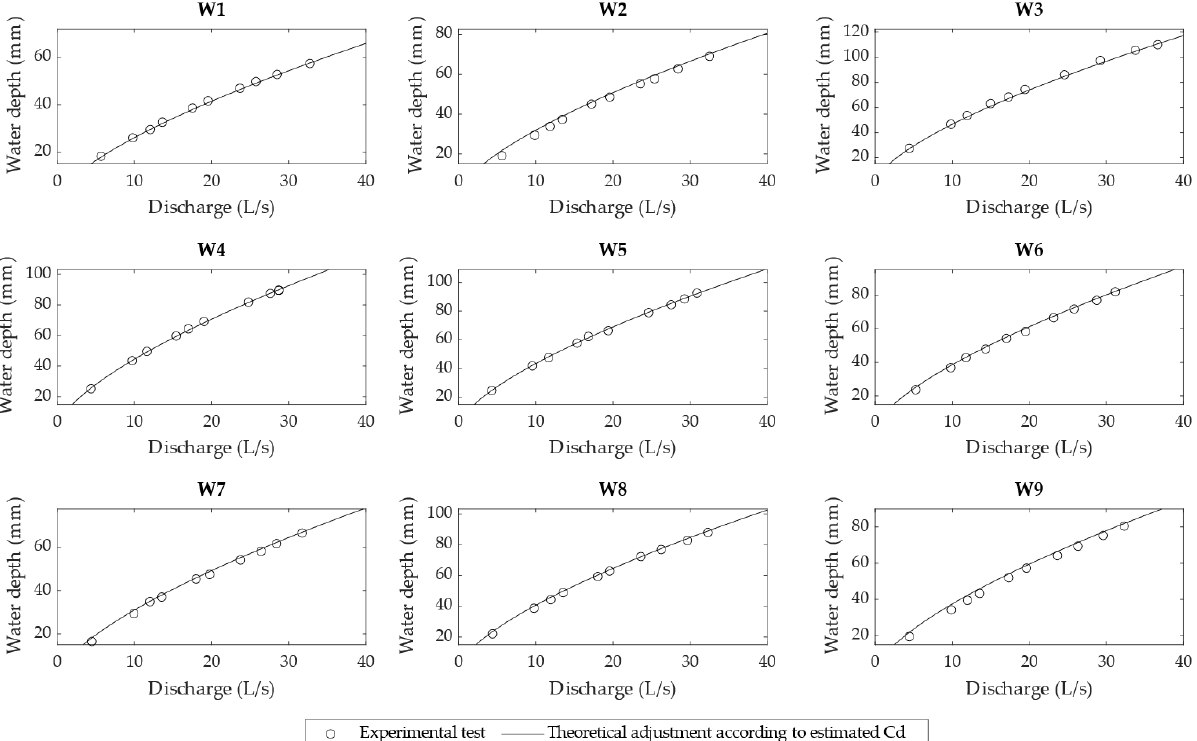
Figure 7. Theoretical adjustment of the discharge curves obtained in the experimental tests for the estimated Cd. Water